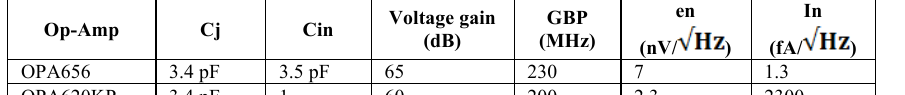
Table 1. Parameters of the Op-Amp used